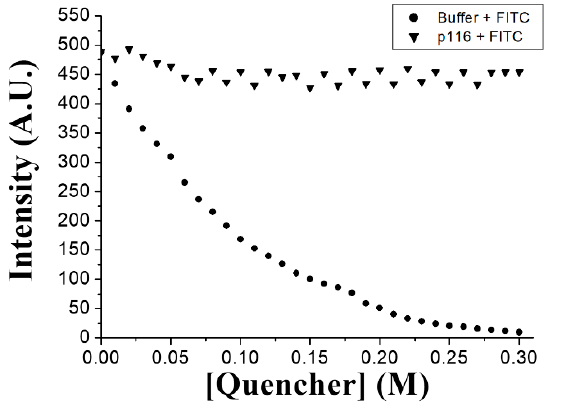
Figure 4. FITC fluorescence quenched by the quencher iodide. In the graphs, ( ▼ ) indicates the relative fluorescence intensity of free-form FITC in the presence of different quencher concentra- tions; ( ● ) indicates the relative fl uorescence intensity of FITC associated with p116-assembled par- ticles in the presence of different quencher concentrations.